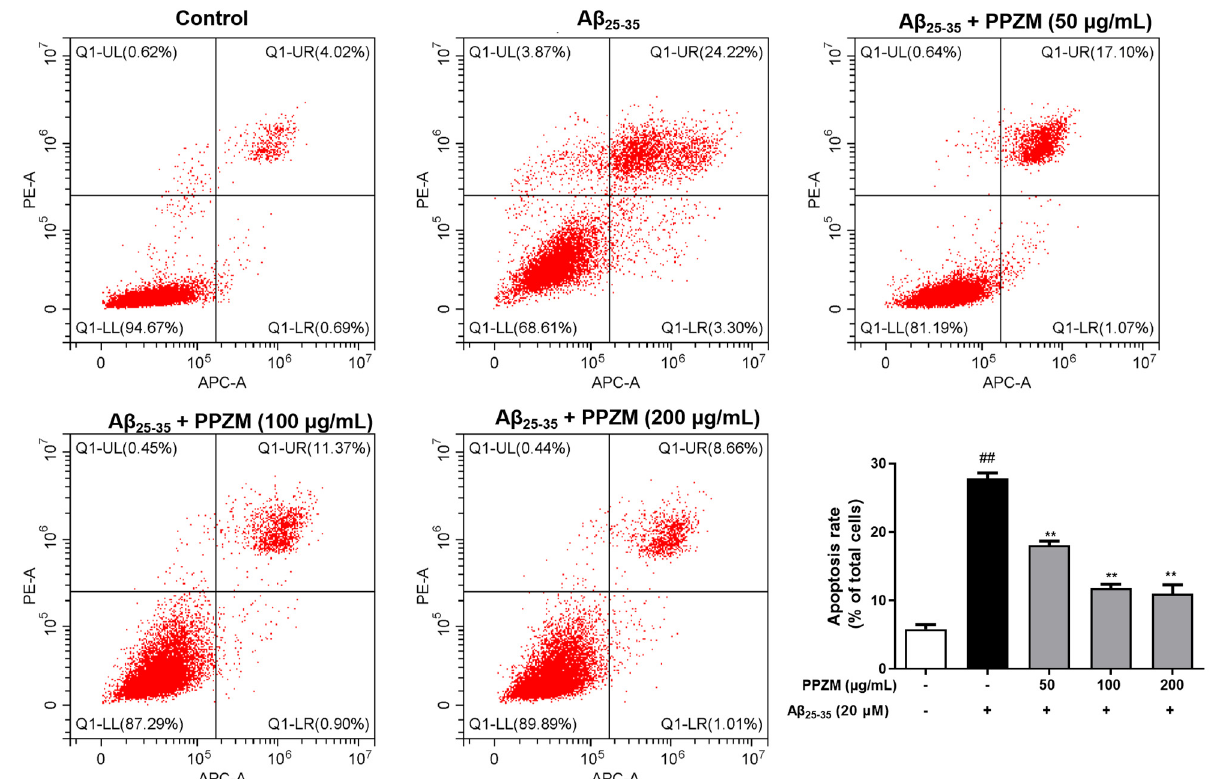
Figure 3. Effects of PPZM on A β 25–35 -induced PC12 cell apoptosis based on flow cytometry analysis. Results are presented as the mean ± SD. ## p < 0.01 vs. the control group; ** p < 0.01 vs. the A β 25–25 treated group.